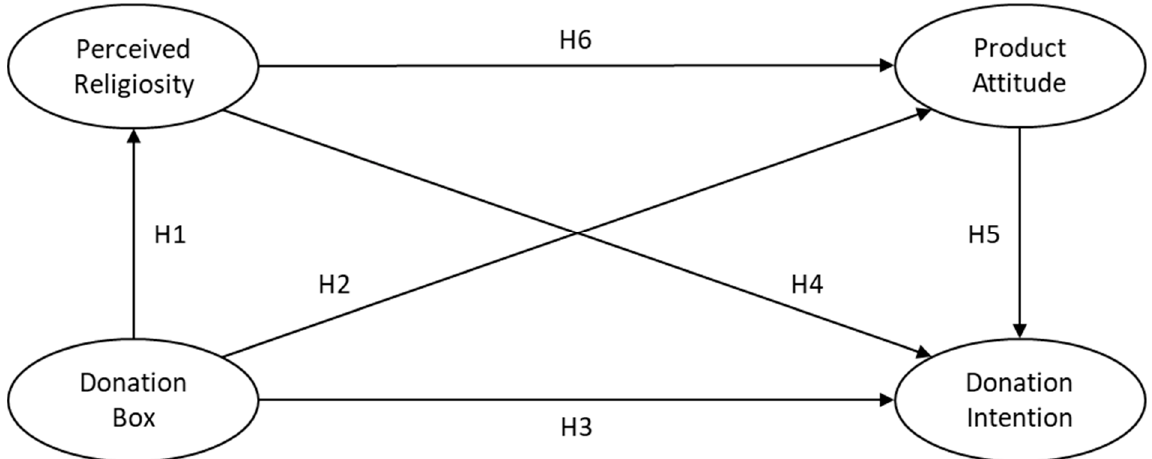
Figure 1. The research framework of the current study.